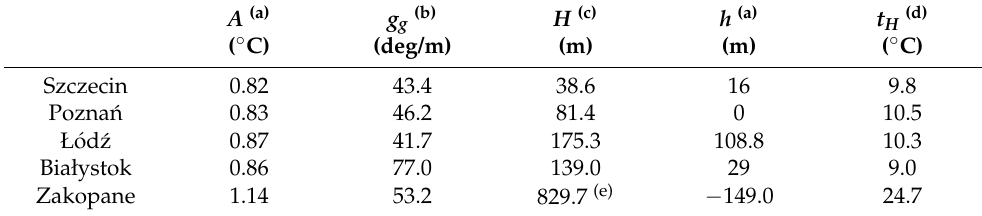
Table 6. The groundwater basins’